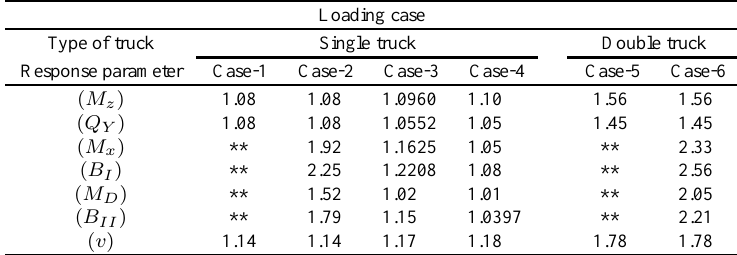
Table 5 Effect of loading position on impact factor